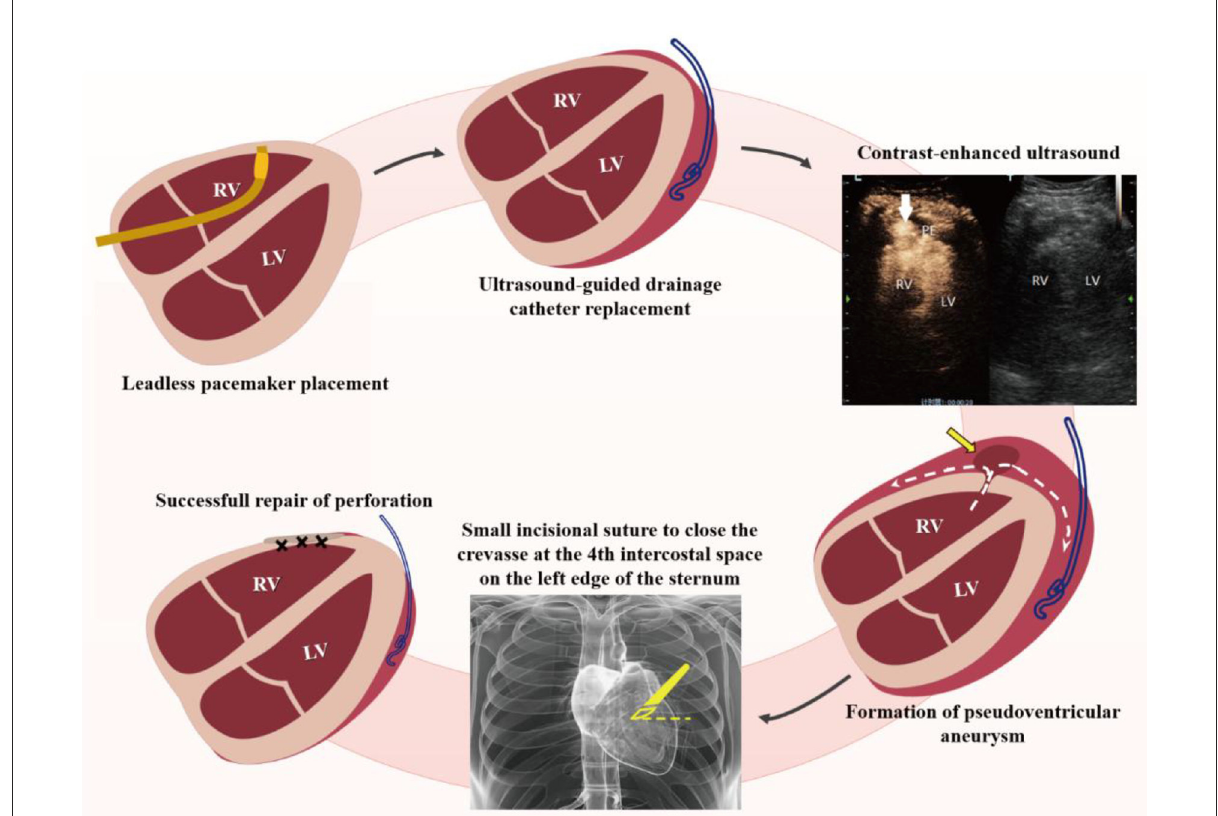
FIGURE2 Schematic diagram of treatment for iatrogenic right ventricular perforation. RV, right ventricle; LV, left ventricle; PE, pericardial effusion.